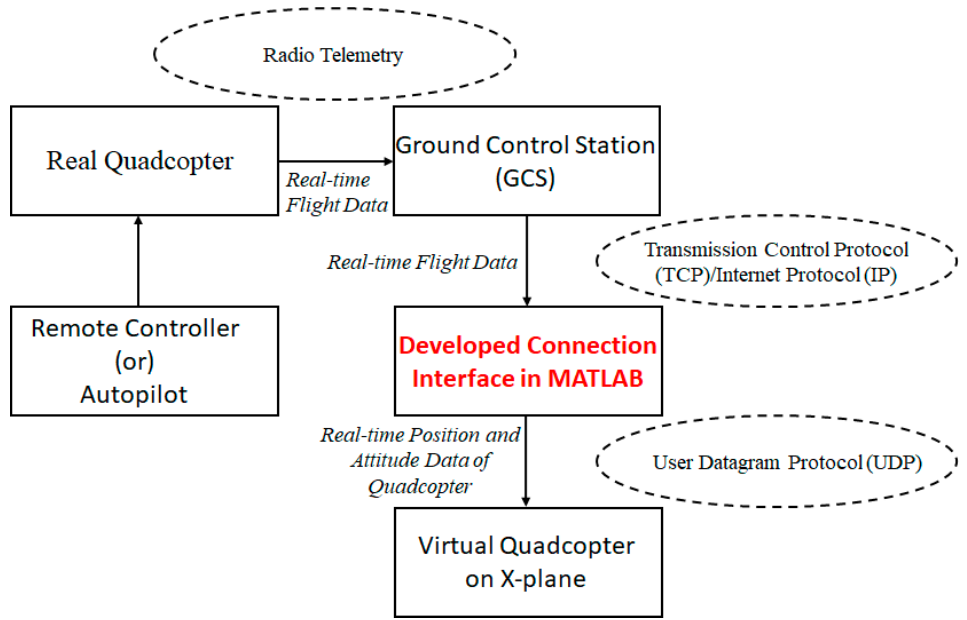
Figure 1. Data flow between the real and the virtual quadcopters (overview of mixed reality simulation).